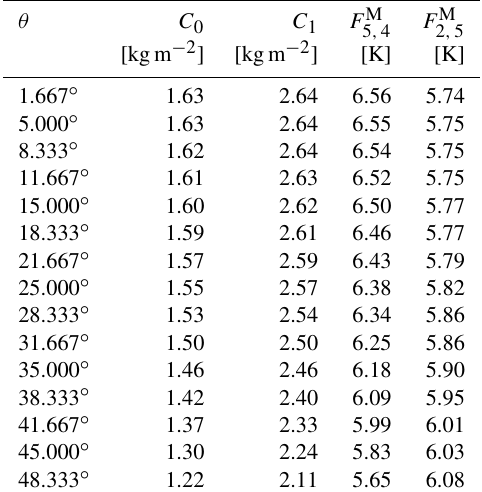
Table A2. Calibration parameters for the Arctic mid-TWV algo- rithm.